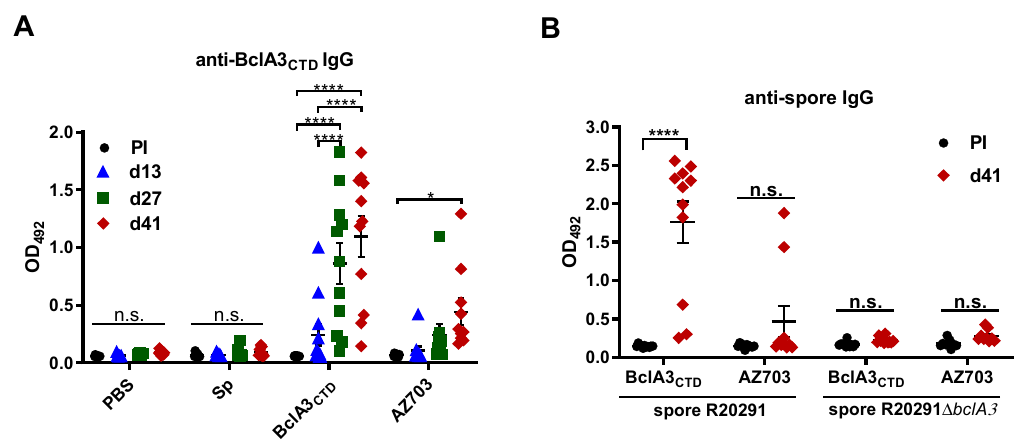
Figure 4. Evaluation of IgG anti-BclA3 CTD and anti- C. di ffi cile spores R20291 and R20291 ∆ bclA3 titers on mice serum. ELISA plates coated with 50 ng / well of purified BclA3 CTD ( A ) or 1.6 × 10 7 spores / well of C. di ffi cile R20291 or R20291 ∆ bclA3 spores ( B ) were incubated with 1:100 of mice serum immunized on days 0 (Pre-Immune serum, PI), 13 (d13, before second immunization), 27 (d27, before third immunization) or day 41 (d41, before infection with C. di ffi cile spores). The assessment of specific IgG anti-BclA3 CTD and anti-spores was obtained using the secondary antibody 1:5000 anti-IgG mouse HRP. Results are reported as optical density (OD) units at 492 nm. The geometric mean plus standard error of the mean for each cohort are shown. Comparisons between days in the same group were obtained using two-way ANOVA and Tukey’s multiple comparison test; statistical significance ( p < 0.05) is indicated by asterisks. * p < 0.05 and **** p < 0.0001. No significance (n.s).